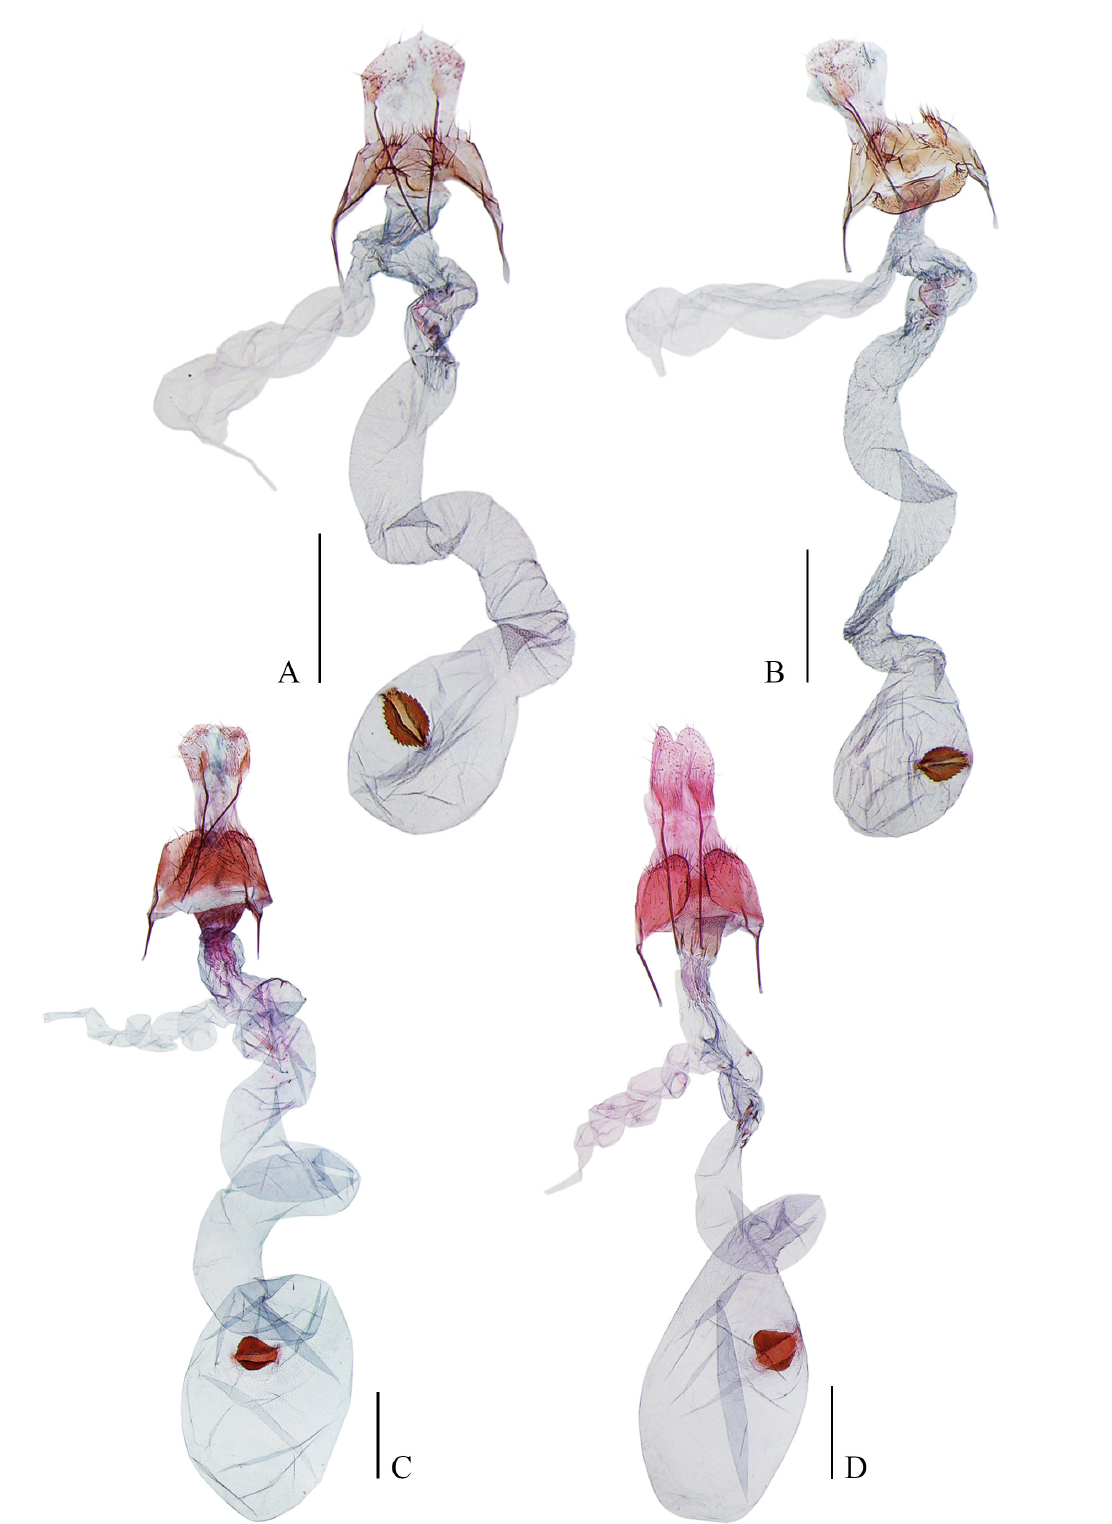
Fig. 4. Female genitalia of Antiochtha spp. A . A. erromera sp. nov., paratype, slide No. YS20065. B . A. hainanensis sp. nov., paratype, slide No. YS20228. C . A. jianfengensis , slide No. YS20074. D . A. semialis Park, 2002, slide No. YS20275. Scale bars = 0.5